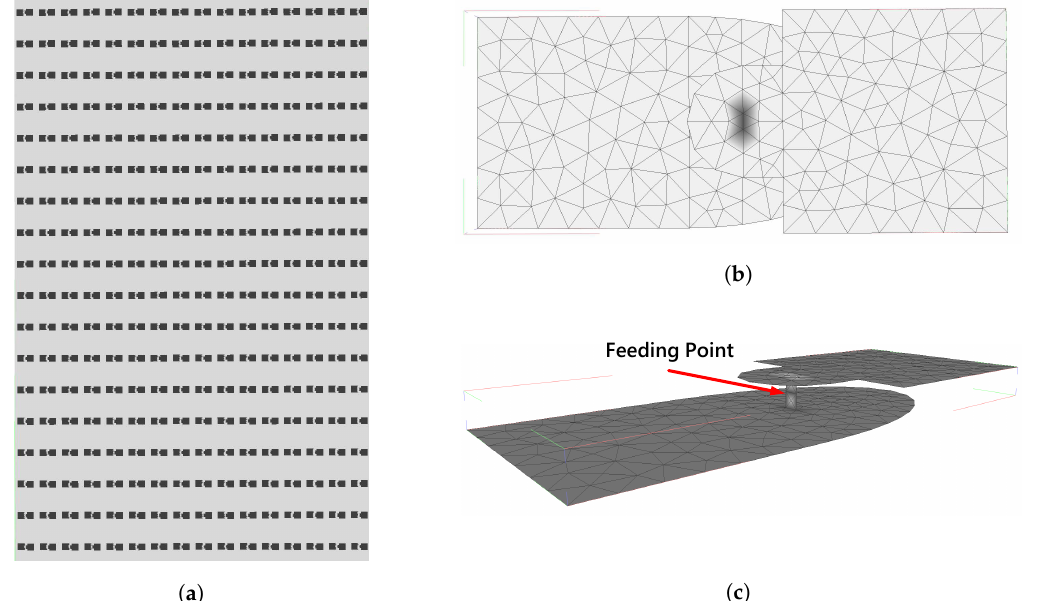
Figure 8. ( a ) The layout of the patch antenna array. ( b ) The plan view of a single patch antenna. ( c ) The 3D view of a single patch antenna.